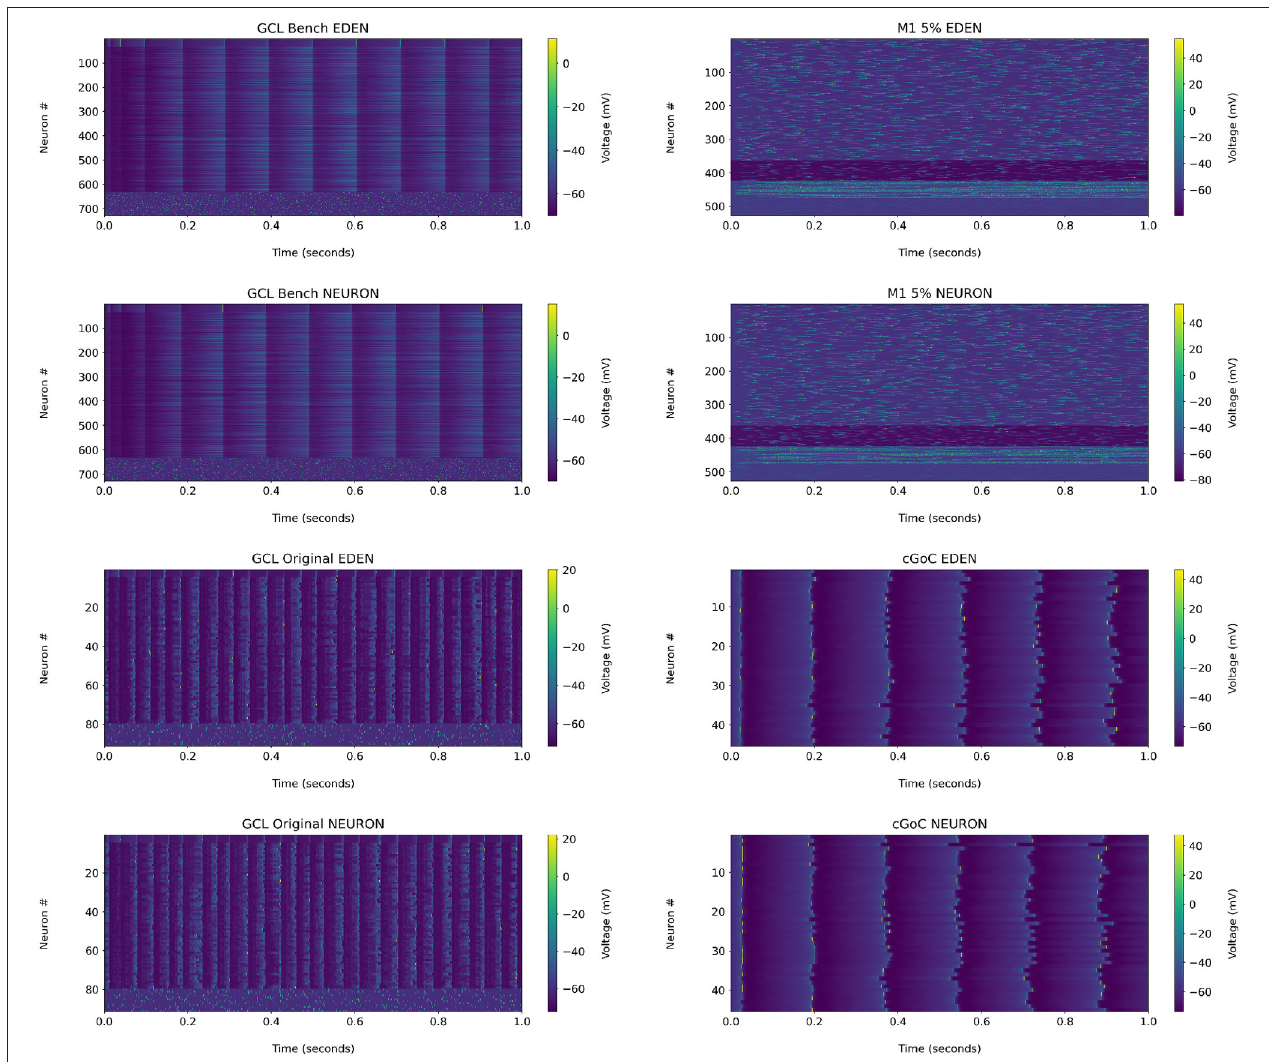
FIGURE 8 | Raster plots for each network used in the performance benchmarks, when run on NEURON and EDEN. Note that the input stimuli are pseudo-randomly